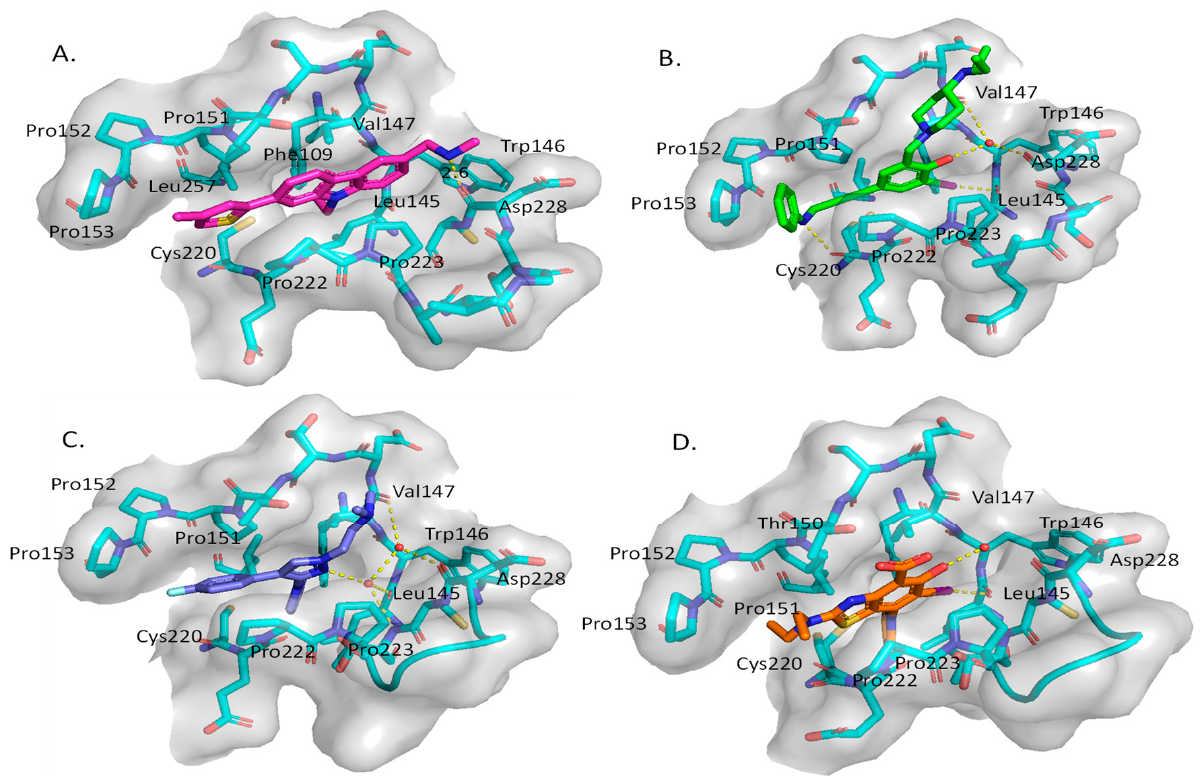
Figure 14. Co-crystal structure of binders of Y220C: ( A ) PK9328; ( B ) PK5196; ( C ) PK7242; ( D ) and MB710.